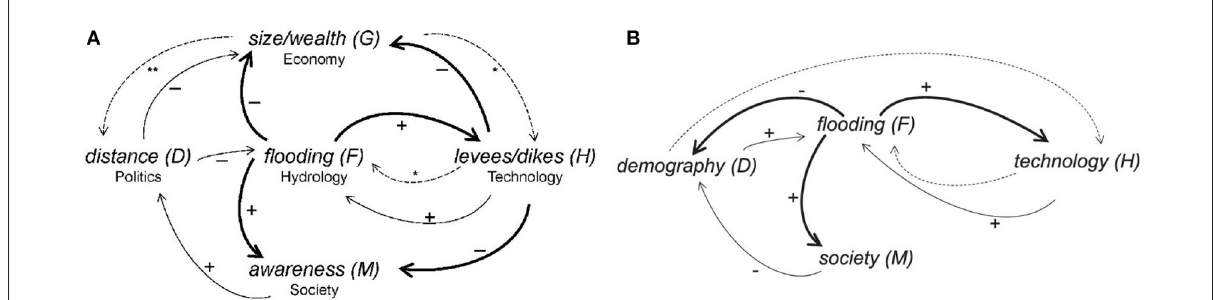
FIGURE2 Descriptions of the socio-hydrological human-flood models of (A) Di Baldassarre et al. (2013) and (B) Di Baldassarre et al. (2015) (reproduced with